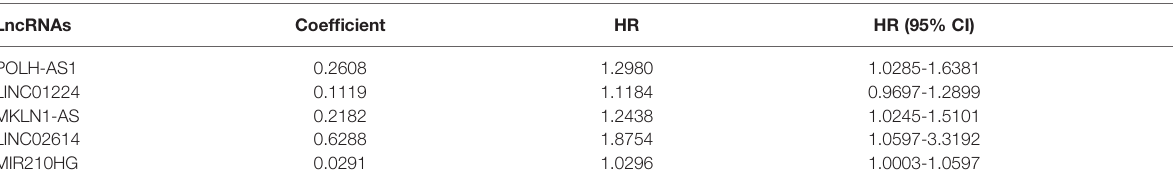
TABLE 2 | Multivariate cox regression analysis of fi ve prognostic lncRNAs.